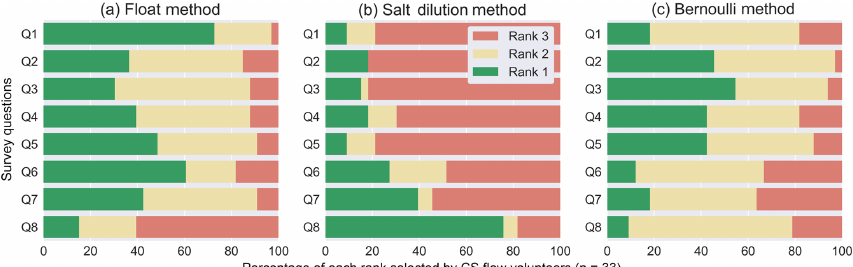
Figure 5. Results of the CS Flow group perception questions for (a) float, (b) salt dilution, and (c) Bernoulli methods. Questions Q1 through Q8 are shown on the vertical axis. Percentages of each rank selected by CS Flow citizen scientists ( n = 33) are shown on the horizontal axis. Questions were worded so that in all cases a rank of 1 was most favorable and 3 was least favorable. Questions are as follows (also included in Table 3): Q1 – required training (rank 1 meaning least and 3 most); Q2 – cost of equipment (rank 1 meaning least and 3 most); Q3 – number of citizen scientists required (rank 1 meaning least and 3 most); Q4 – data-recording requirements (rank 1 meaning least and 3 most); Q5 – complexity of procedure (rank 1 meaning least and 3 most); Q6 – enjoyability of measurement (rank 1 meaning most and 3 least); Q7